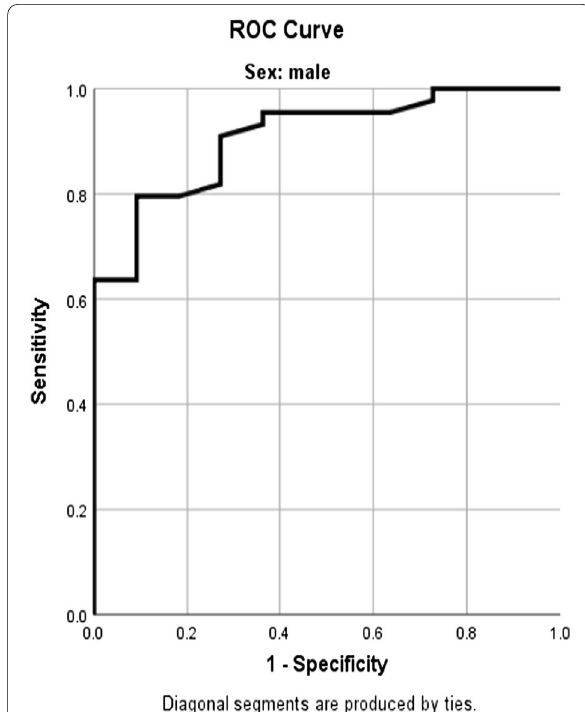
Fig. 11 Cut off value of male quadriceps index